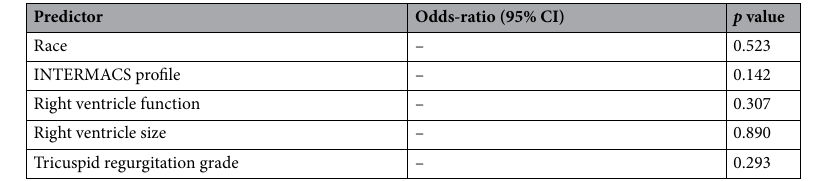
Table 4. Likelihood ratio test p value corresponding to each categorical risk factor for early right heart based on univariate logistic regression models (omitting odd-ratios as there are multiple per variable). INTERMACS: interagency registry for mechanical circulatory support.